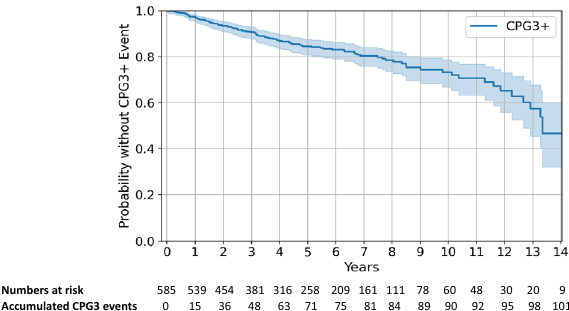
Fig. 1 Kaplan Meier plot and con fi dence intervals of the cohort. The number and time to event to Cambridge Prognostic Group 3, censored or still on Active Surveillance over the period of follow-up and since the date of